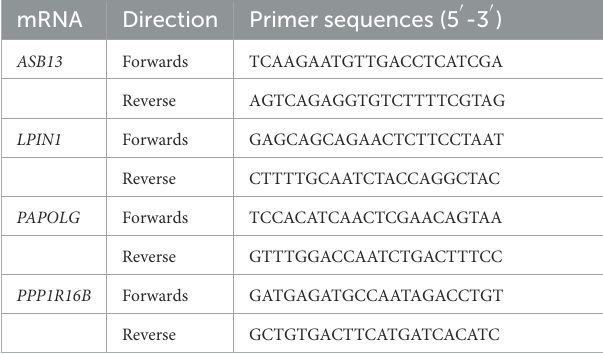
TABLE 1 Real-time fluorescence quantitative PCR primer